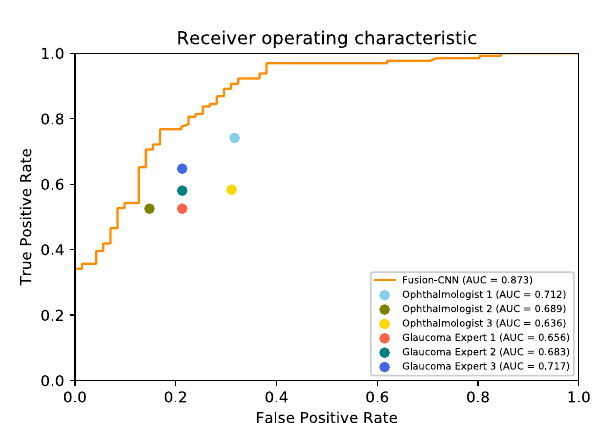
Fig. 1 Comparison of diagnostic performance of the 2D-Fusion- CNN in VF interpretation with ophthalmologists in test set 1. The fi gure shows receiver operating curve of glaucoma diagnosis by the 2D-Fusion-CNN (ND + NDP + PDP) in test set 1. 2D-Fusion-CNN combining pattern deviation probability plots (PDPs), numerical pattern deviation plots (NDPs), and numeric displays (NDs) as training data outperformed all the ophthalmologists with an AUC of